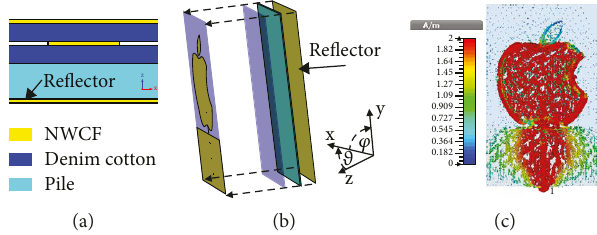
Figure 2: Modi fi ed design: (a) side view; (b) prospective view; (c) surface current distribution at